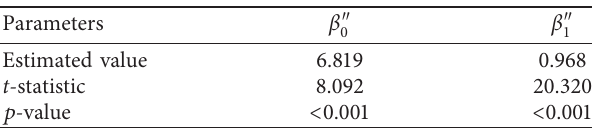
Table 6: Parameter estimations of bus dwell time model based on